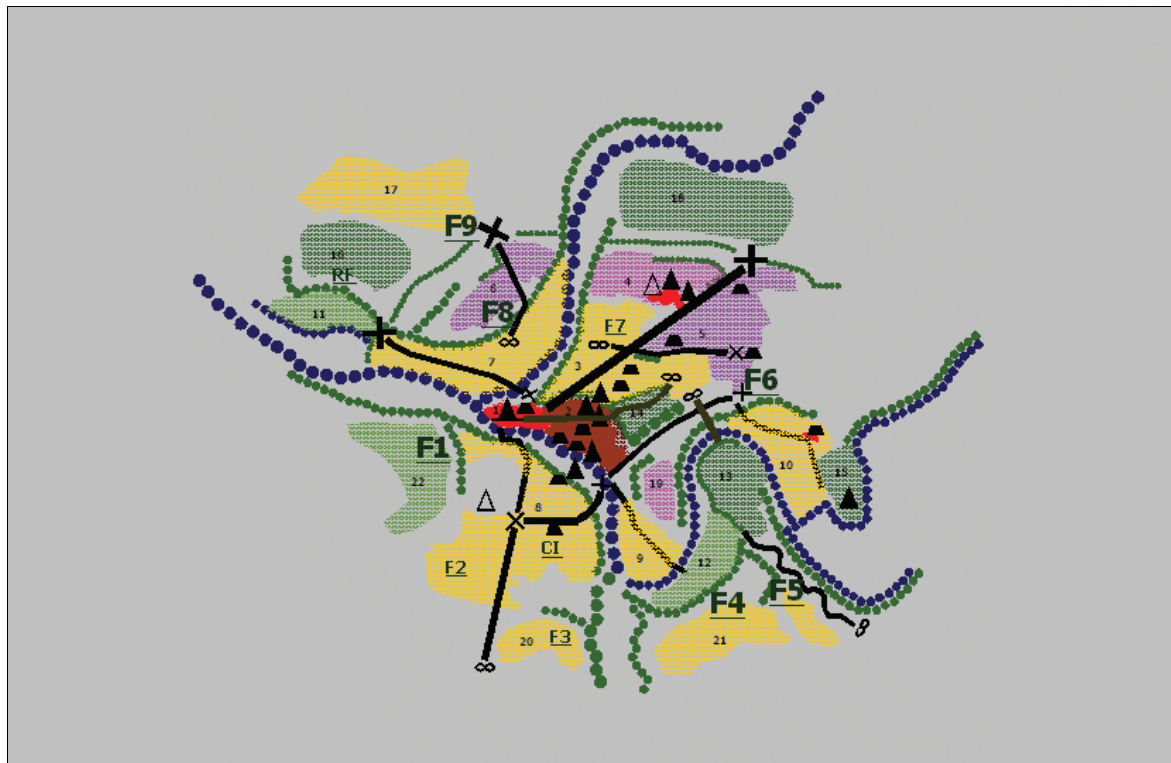
Fig. 2. Main components of kaunas city image and objects of kaunas